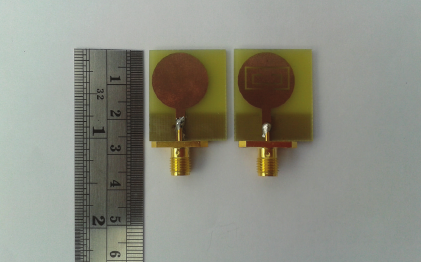
Figure 5: Photograph of the prototyped antenna.